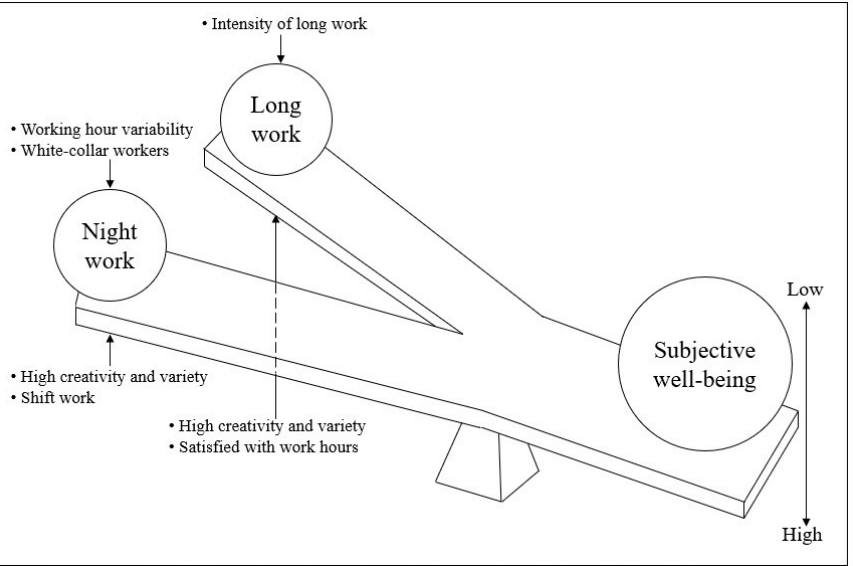
Figure 3. Theoretical framework of relationship between subjective well-being, long working hours, and night work. and night